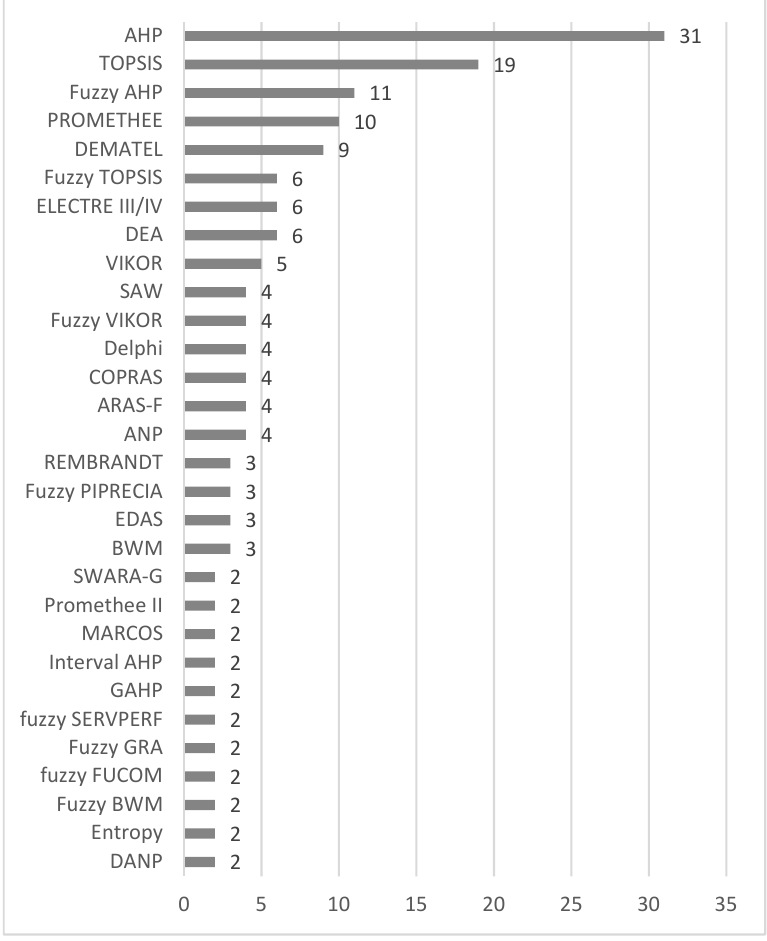
Figure 1. The most popular MCDM/MCDA methods used in the field of transport between 2000 and 2021. Source: author’s work.